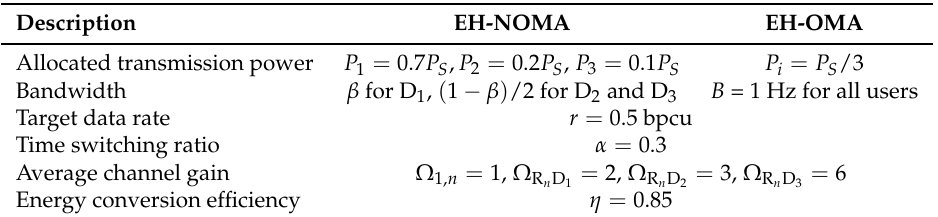
Table 2. Parameter settings of EH-NOMA and EH-OMA relaying